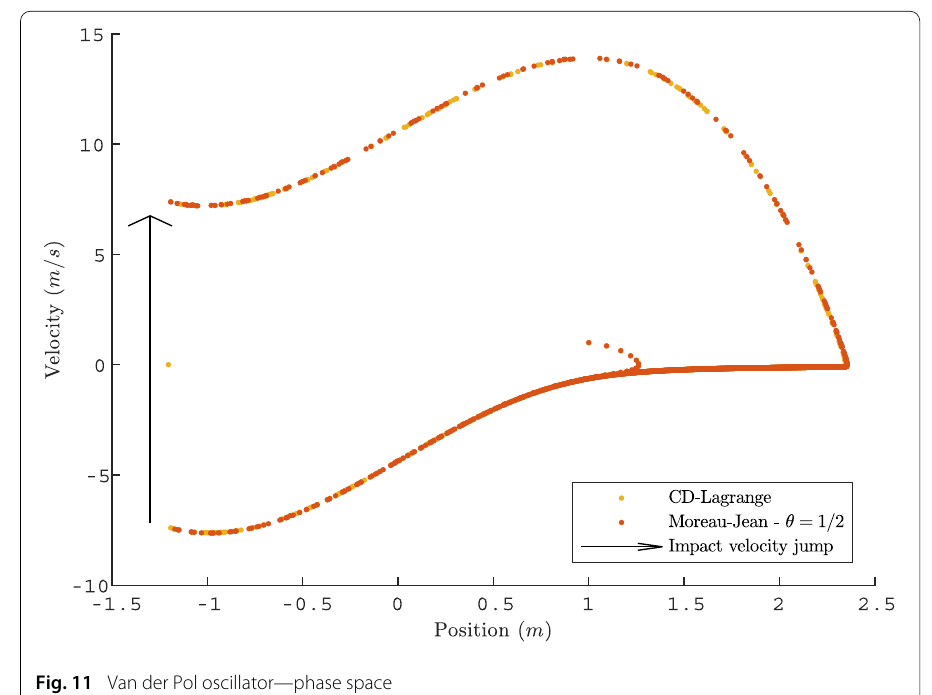
Fig. 11 Van der Pol oscillator—phase